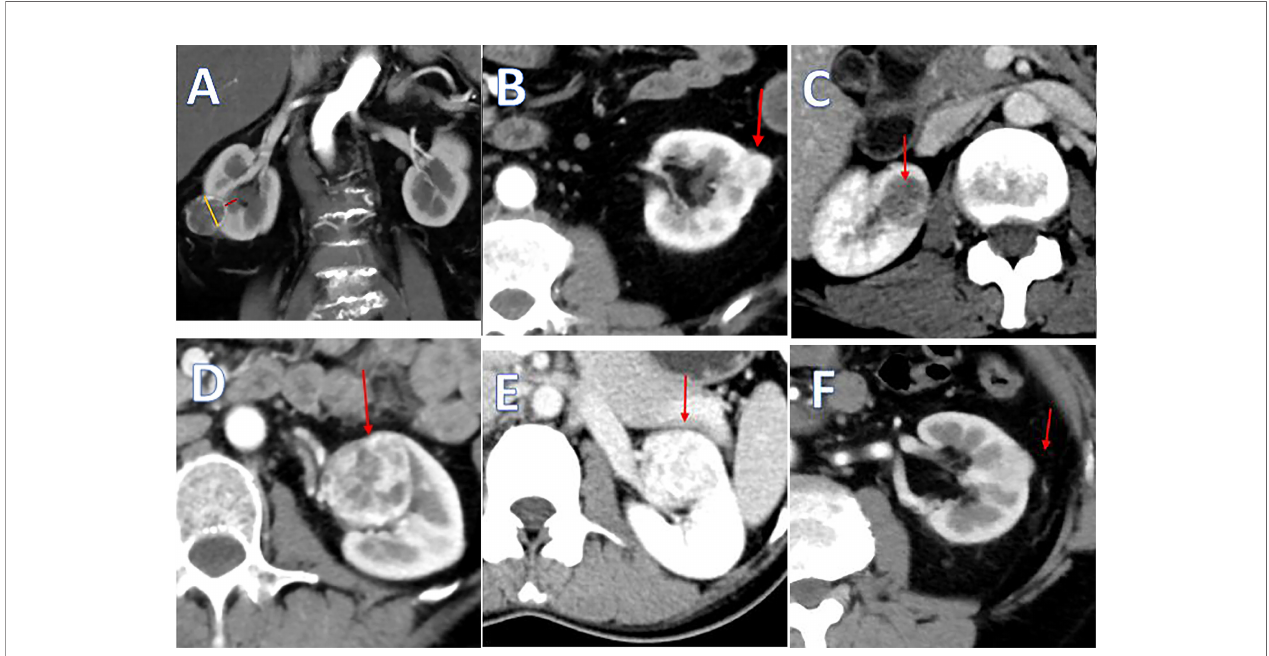
FIGURE 1 | (A) The yellow line means the intrarenal diameter of mass, and the red line means distance of the tumor to collecting system. (B) Tumor located at the lateral pole. (C) Tumor located at the endophytic pole. (D) Tumor located at the hilar pole. (E) Kidney with thin or hardly any perinephric fat. (F) Kidney with thick perinephric